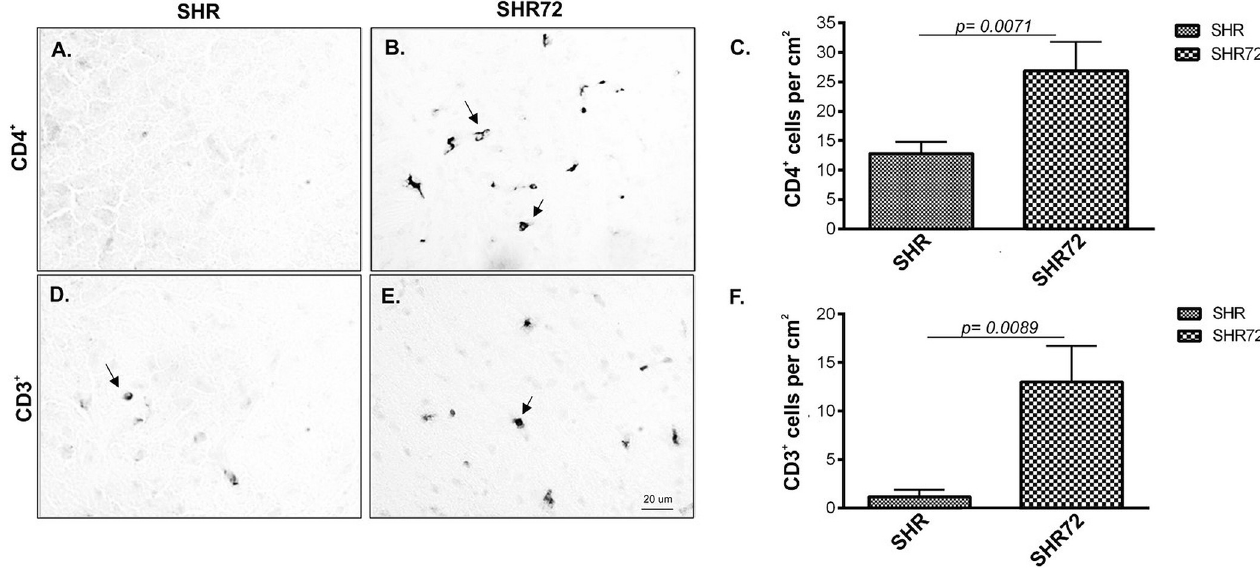
Fig 1. CD3 + T-cell and CD4 + T-cell occurrence in SHR-72 transgenic rat model for tauopathies compare to control animals. (A) CD4 + T-cell in SHR rats. (B) CD4 + T-cell in SHR-72 rats. (C) Quantification of CD4 + T-cell in control and transgenic animals. (D) CD3 + T-cell in SHR rats. (E) CD3 + T-cell in SHR-72 rats. (F) Quantification of CD3 + T-cell in control and transgenic animals. Scale bar 20 μ m, n = 5. space (Fig 3T, 30 ± 2.182 vs . 14.29 ± 3.689, p = 0.0032; n = 7). We observed only a few intrapar-